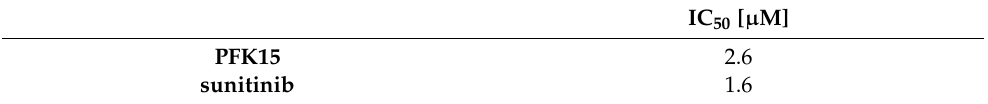
Table 1. The IC 50 values for PFK15 and sunitinib determined on